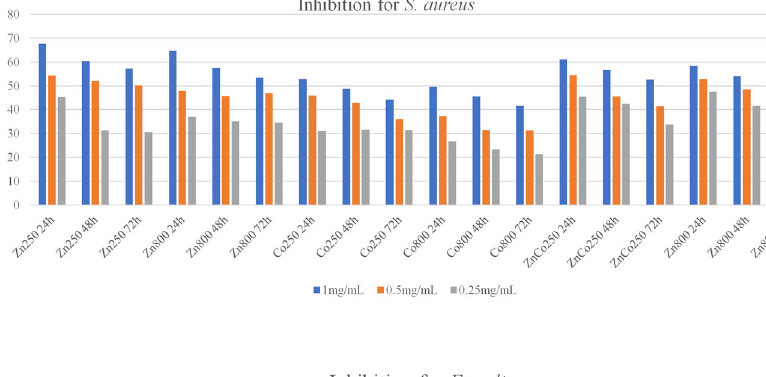
Fig. 7 Percentage of growth inhibition of S. aureus